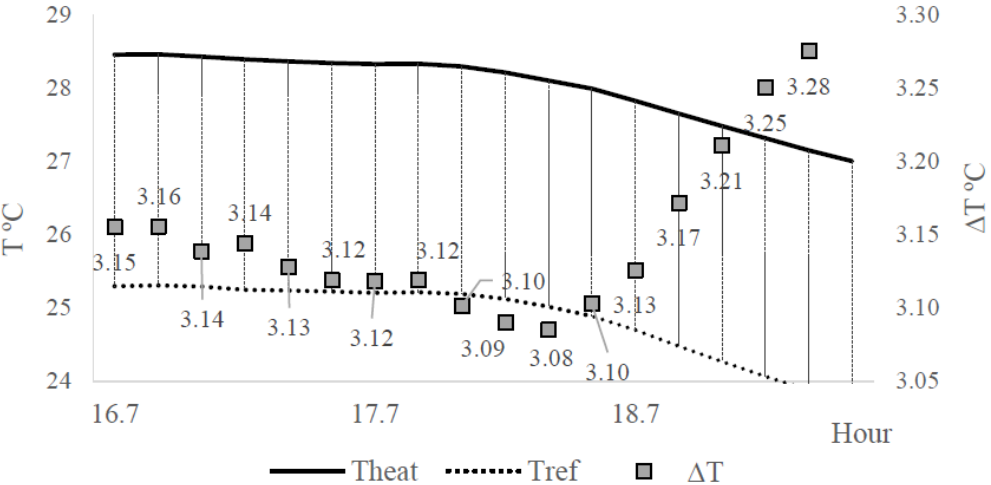
Figure 6. Peak observed in the sap flux density measurements (Experiment I). Left vertical axis: temperature (T, °C). Right vertical axis: temperature difference (∆T, °C).